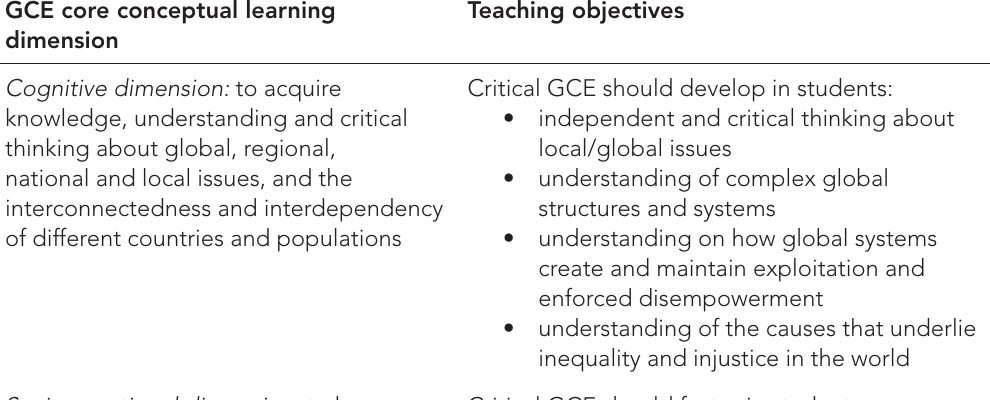
Table 2: Teaching objectives for critical GCE GCE core conceptual